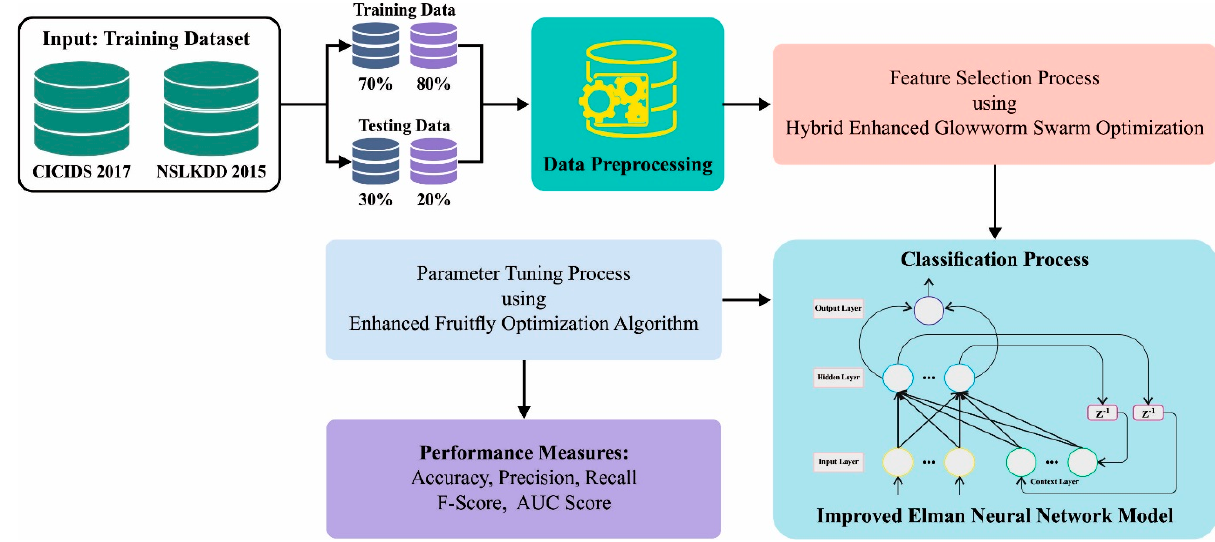
Figure 2. Overall flow of XAIID-SCPS system.